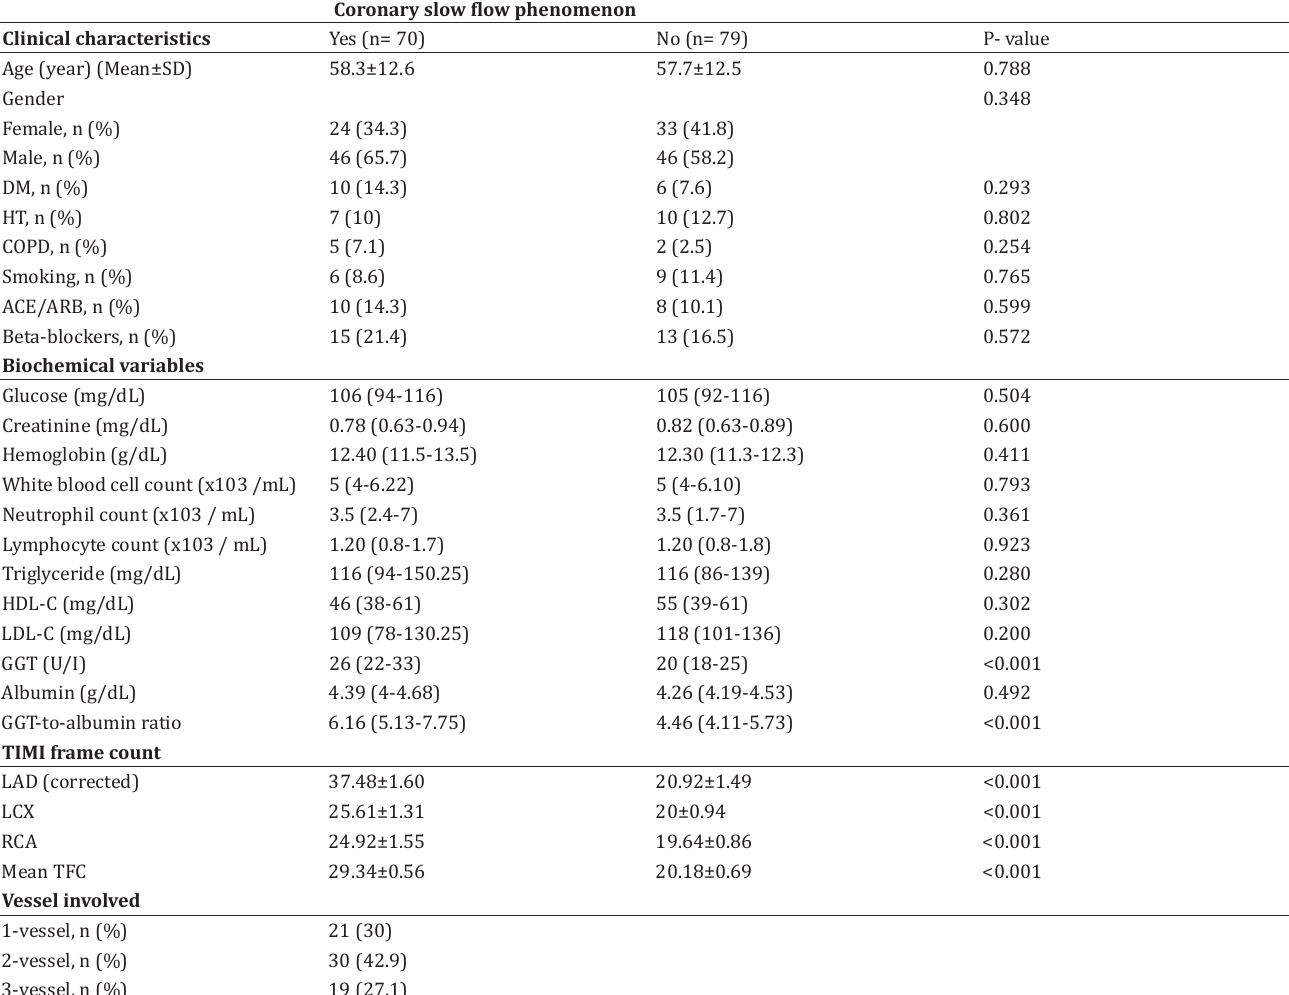
Demographic and laboratory findings of patients Coronary slow flow phenomenon Clinical characteristics